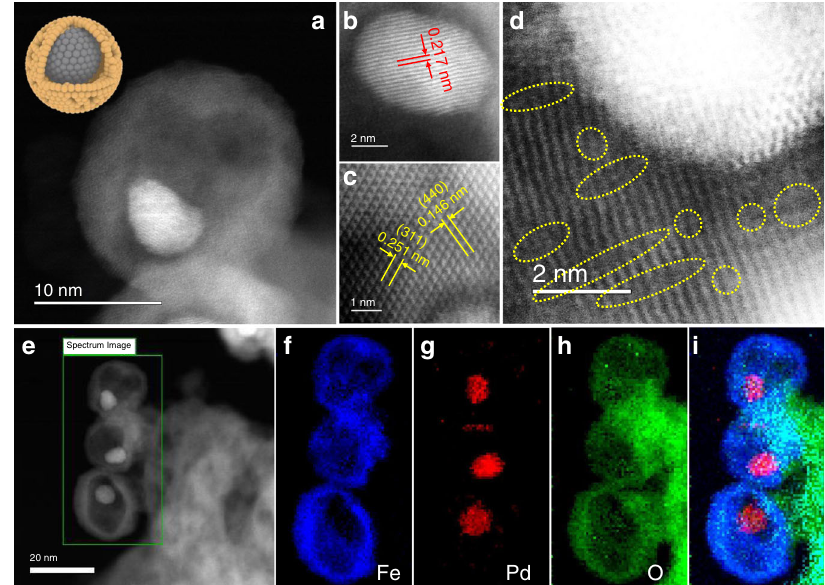
Fig. 2 STEM characterization of the Pd – Fe 3 O 4 – H sample. a HAADF-STEM image of Pd – Fe 3 O 4 – H and schematic illustration of the structure (the yellow shell stands for Fe 3 O 4 , and grey core stands for Pd); b HR-STEM images of Pd core, c Fe 3 O 4 shell, and d Pd – Fe 3 O 4 – H (voids in oxide shell are marked in yellow circles); e STEM image of Pd – Fe 3 O 4 – H at lower magni fi cation; f – i corresponding EELS elemental mappings of the selected section in e ; f Fe, g Pd, h O, and i overlapped fi